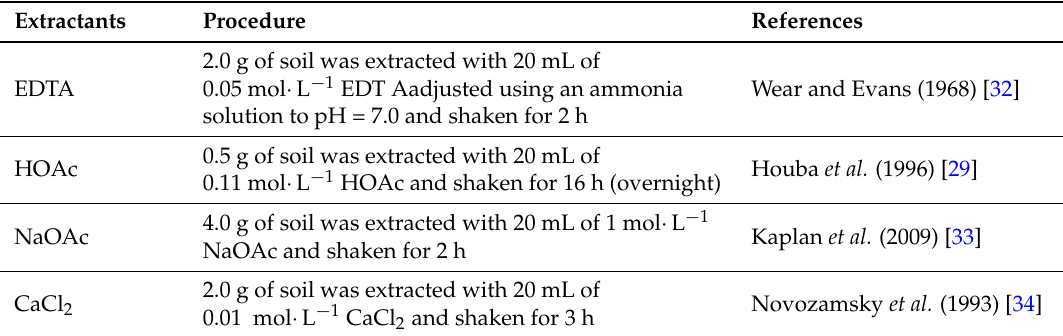
Table 1. The procedures of four extraction methods adopted in this